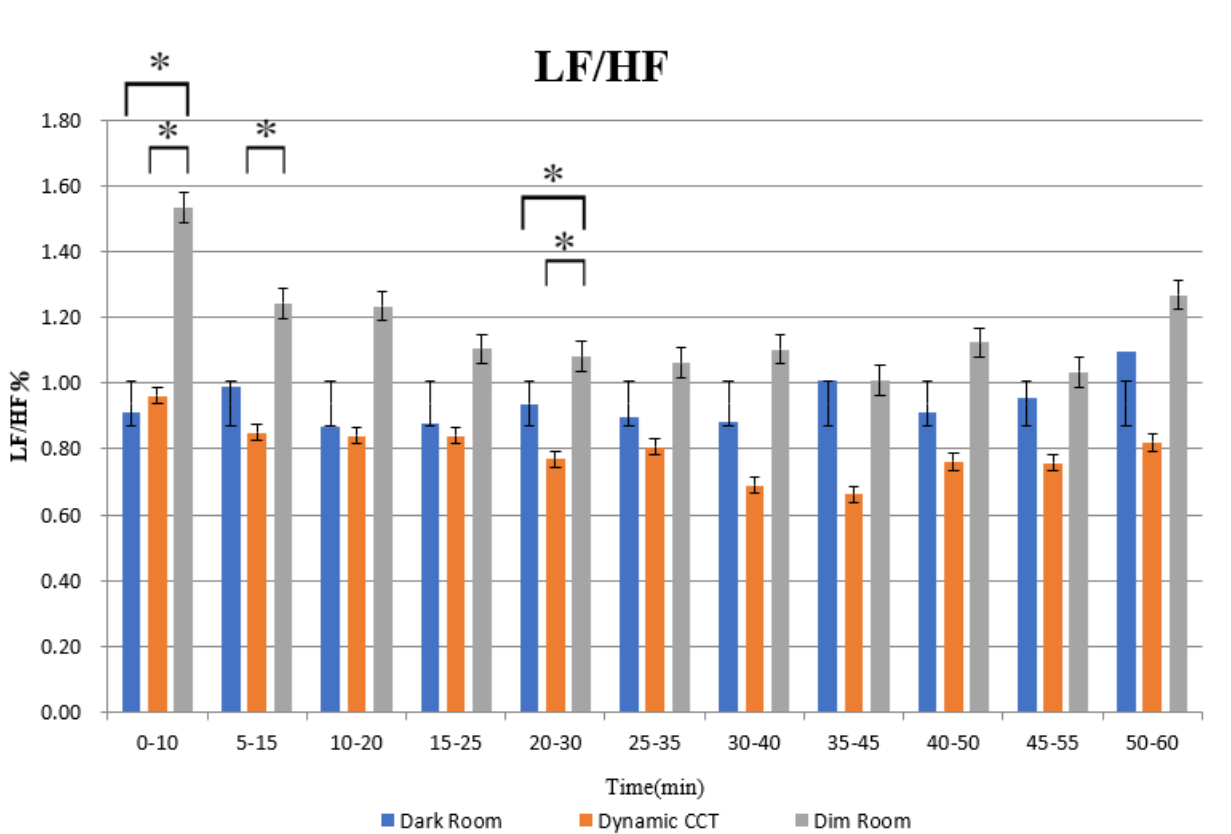
Figure 12. Dark room, Dynamic CCT and Dim light effect comparison chart on LF/HF under sleep environment. “*” is p < 0.05.